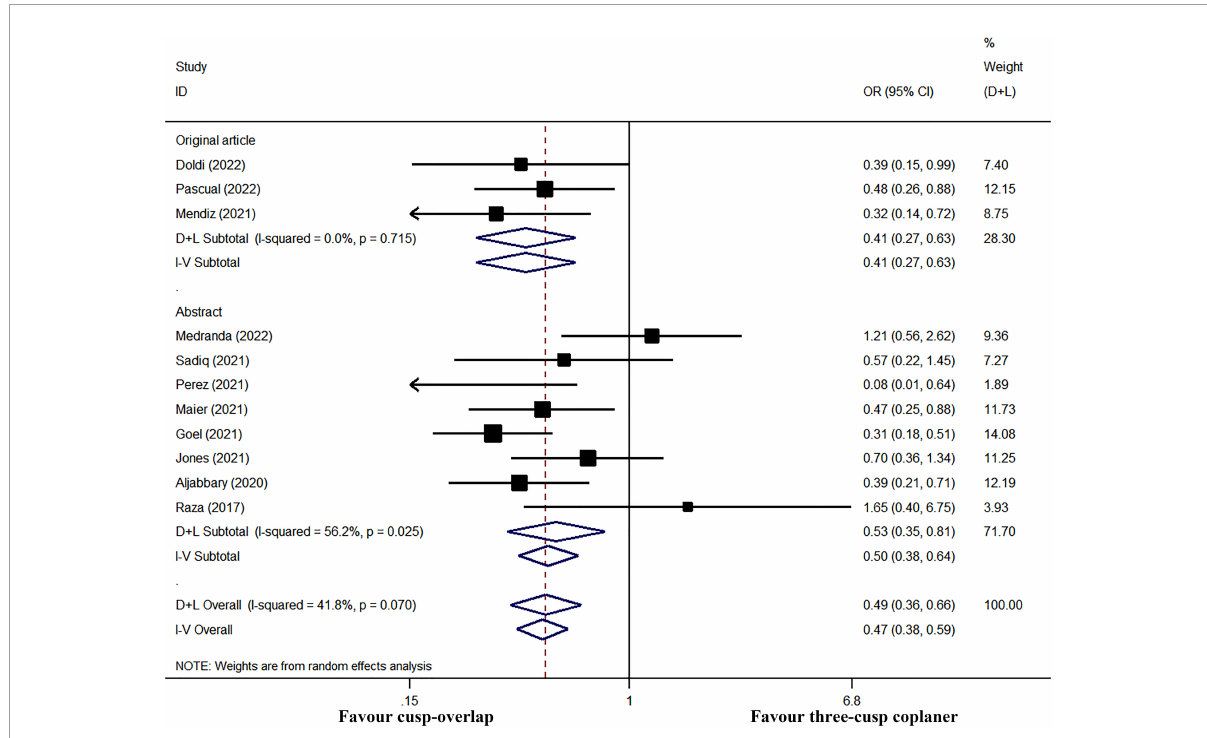
FIGURE7 Subgroup meta-analysis by study type. Both the random-effects model (D + L) and fixed-effects model (I–V) have been presented in the Forrest plot. Significant heterogeneity existed in studies reported in the abstract, while there was no obvious heterogeneity in a subgroup analysis of original article studies. Therefore, the fixed-effects model should be performed in a meta-analysis of post-operative PPI in three original articles, and the random-effects model should be used in subgroup analysis in abstract studies. However, the COP group had a significantly lower risk of PPI in either subgroup meta-analysis.